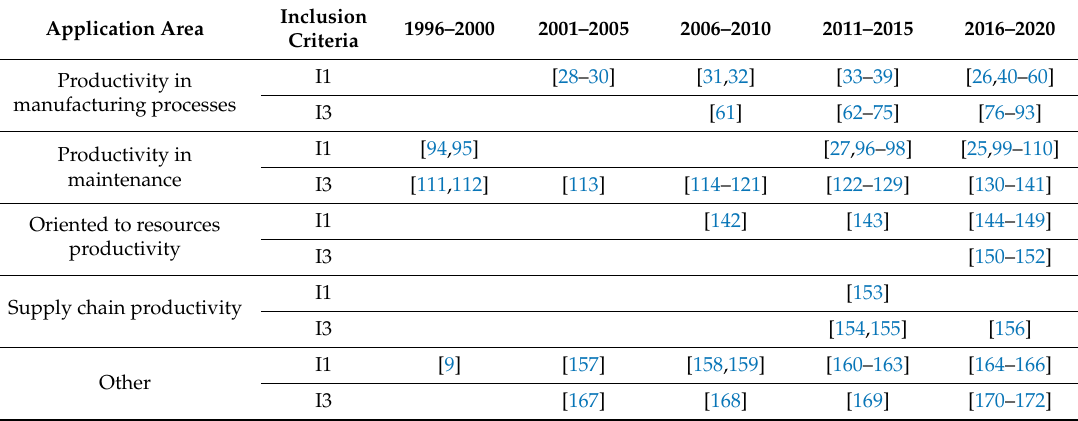
Table 3. Overall equipment effectiveness (OEE) application contribution by area.